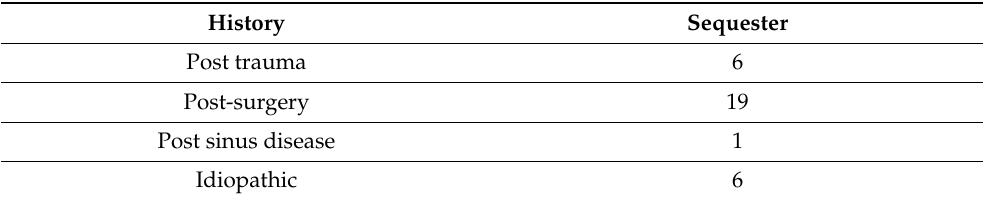
Figure 6. Xray of a horse with mild to moderate, but painful suture exostosis with sequester for- mation.